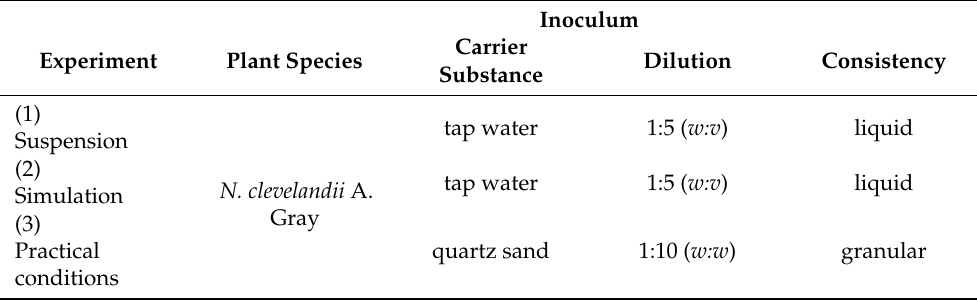
Table 1. Overview of the preparation of different inocula used in experiments 1–3 testing the efficacy of disinfectants against Tomato brown rugose fruit virus